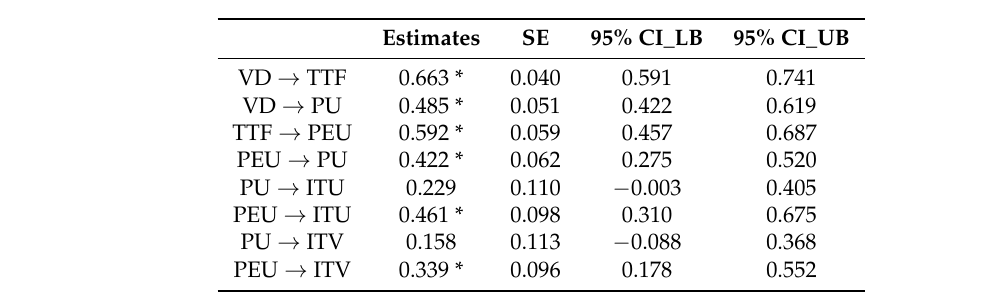
Figure 8. Research model with path coefficients. Table 6. Estimates of path